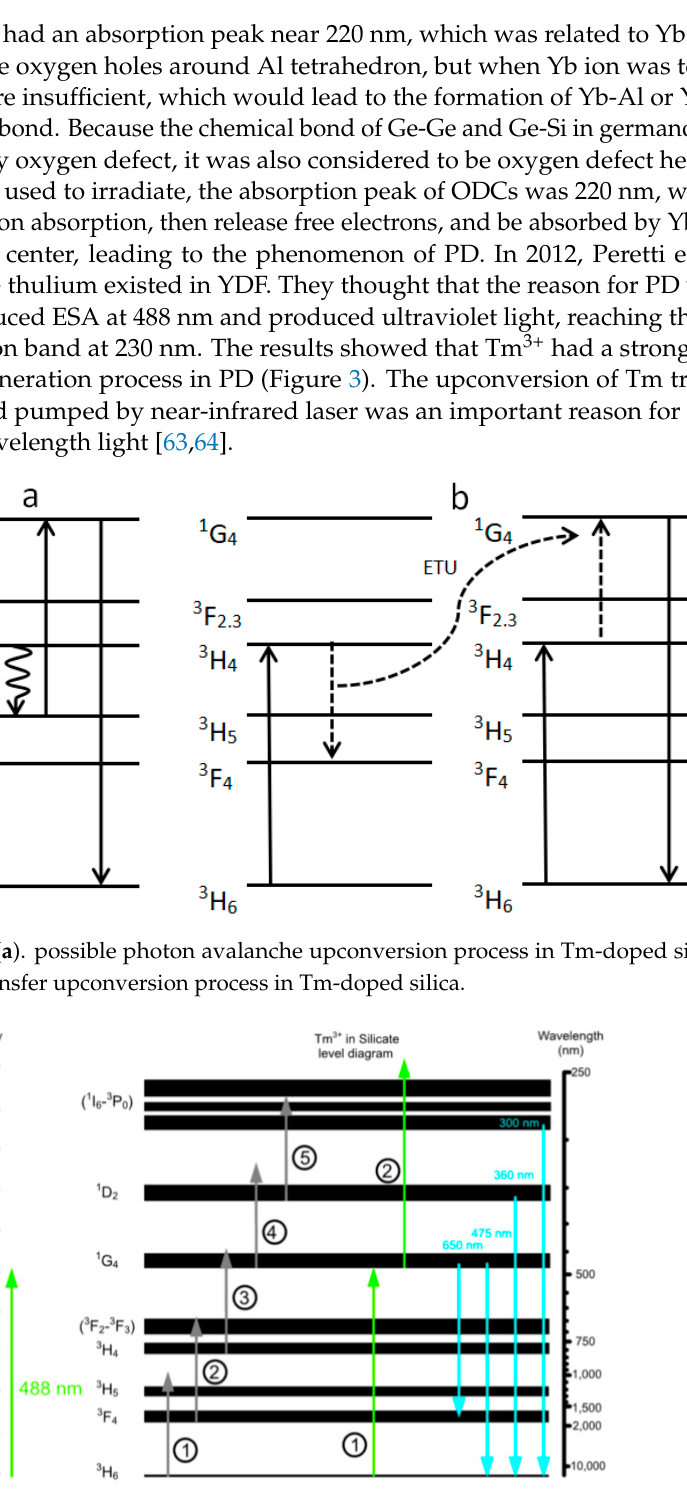
Figure 3. Schematic of conversion processes in Yb/Tm-doped fiber. Reproduced from [62], with the permission of AIP Publishing.